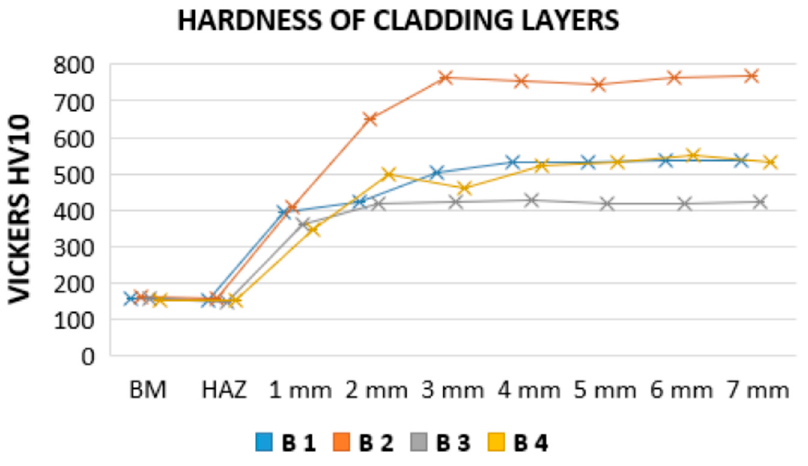
Figure 6. Course of average hardness values from BM, through HAZ to weld clad on samples B1–B4.